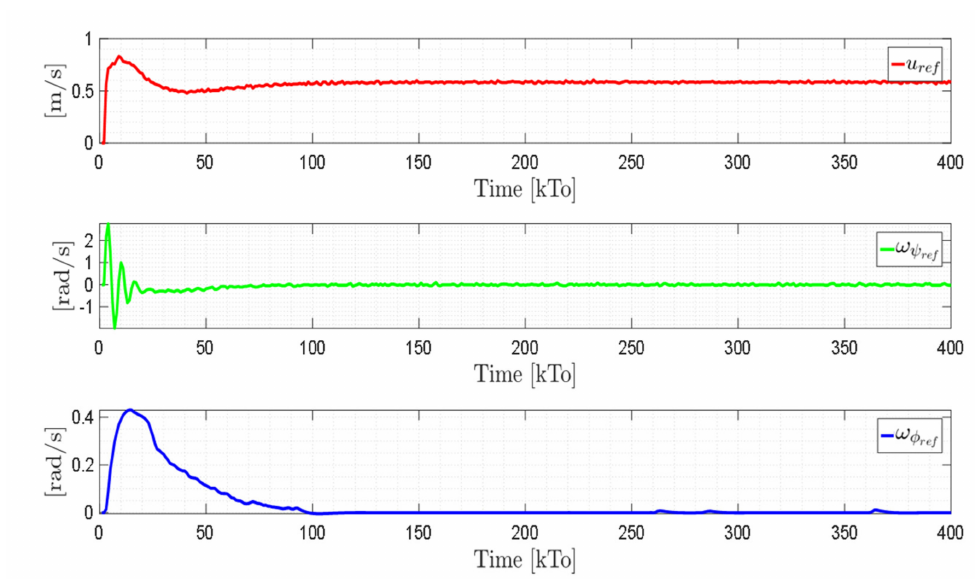
Figure 23. Velocity commands to the standing wheelchair µ ref ( kT 0 ) = ( µ x , ω ψ TRAJECTORY 2. The results of the experiment are illustrated in Figures 24–27. Figure 24 presents the stroboscopic movement of the standing human–wheelchair system, based on real data from trajectory 2. Figures 25 and 26 show that the control errors are ~ (cid:1) ∈ µ (cid:0) (cid:101) u , (cid:101) ω R 3 , respectively, which are limited to values close to zero, i.e., achieving and ψ , (cid:101) ω φ (cid:12) (cid:12) ~ (cid:12) (cid:12) < 0.18 [ m ] . Figure 27 shows the control actions injected ) η ( kT final characteristics errors max 0 (cid:12) (cid:12) into the standing wheelchair robot during the experimental test. From the results obtained, the adequate performance of the proposed controller was